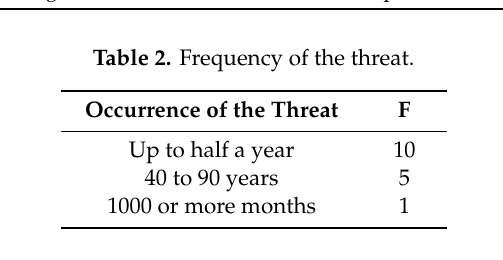
Table 3. Consequence on people coe ffi cient.